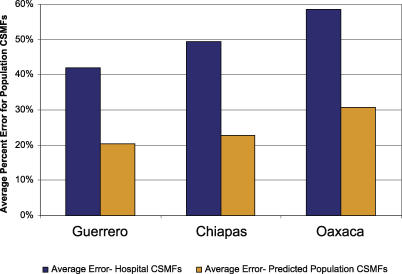
Population CSMFs Average Relative Error for the Three Least-Developed Mexican StatesAverage relative error was estimated on the basis of the proportion of in-hospital deaths by age, sex, and cause groups observed in Distrito Federal and Estado de Mexico.